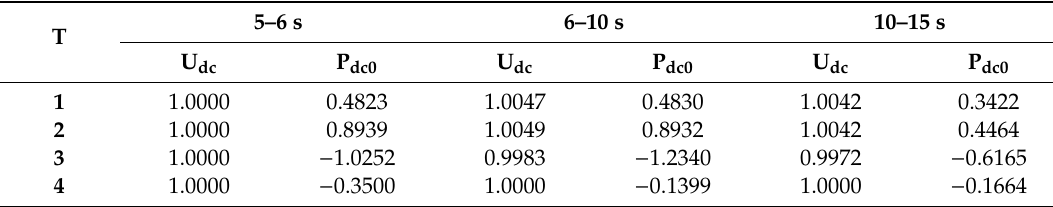
Table A2. The initial nodal voltage and active power reference in the single-point voltage control (p.u.).